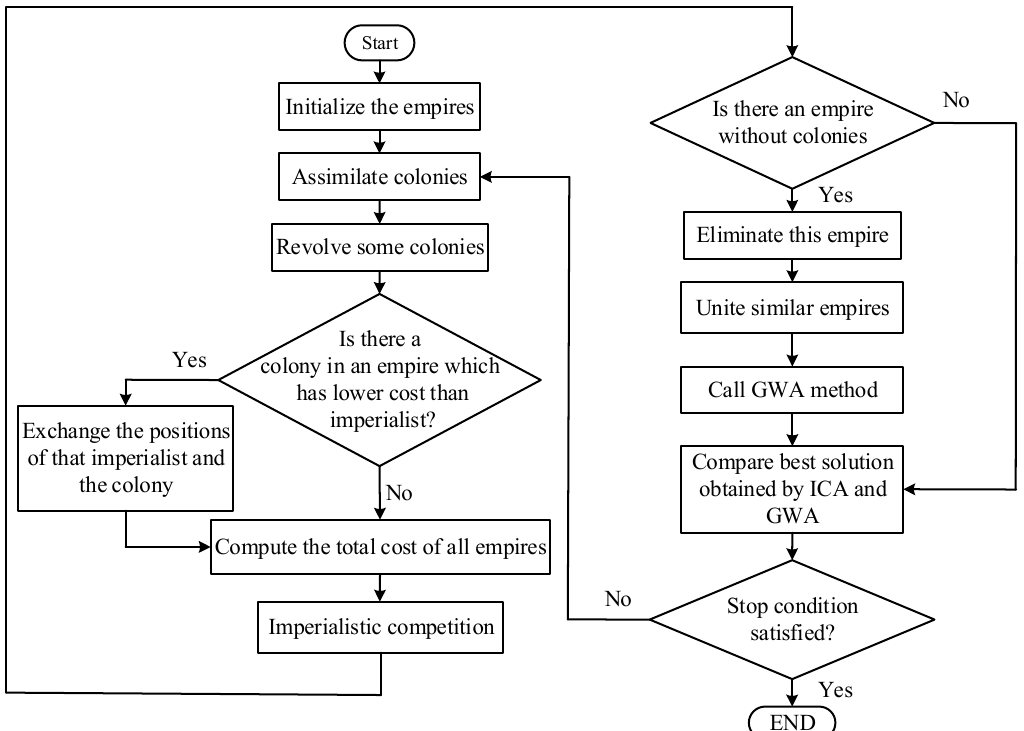
Figure 1. Flowchart of the proposed hybrid imperialist competitive and grey wolf algorithm (HIC- GWA).